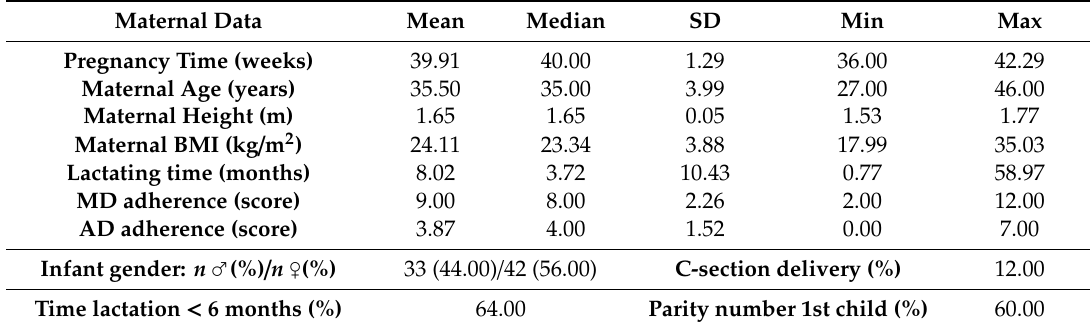
Table 2. Pregnancy and maternal characteristics, continuous and categorical variables ( n = 75).